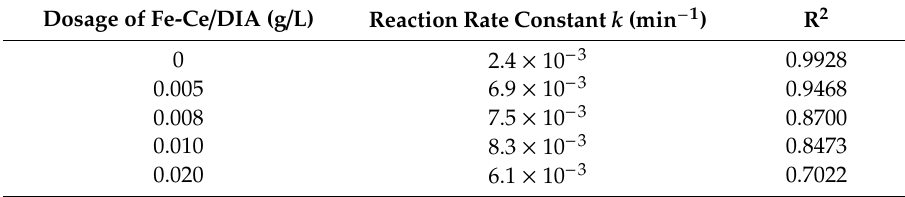
Figure 9. The e ff ects of catalyst dosage ( a ); persulfate dosage ( b ); tetracycline concentration ( c ); pH ( d ) on Tetracycline (TC) removal. Conditions: (Tetracycline) = 200 mL, 50 mg / L, (Catalyst) = 0.02 g, (Persulfate) = 0.476 g, T = 30 ◦ C, 150 rpm. Table 1. The reaction rate of tetracycline degradation at di ff erent dosages of Fe-Ce /